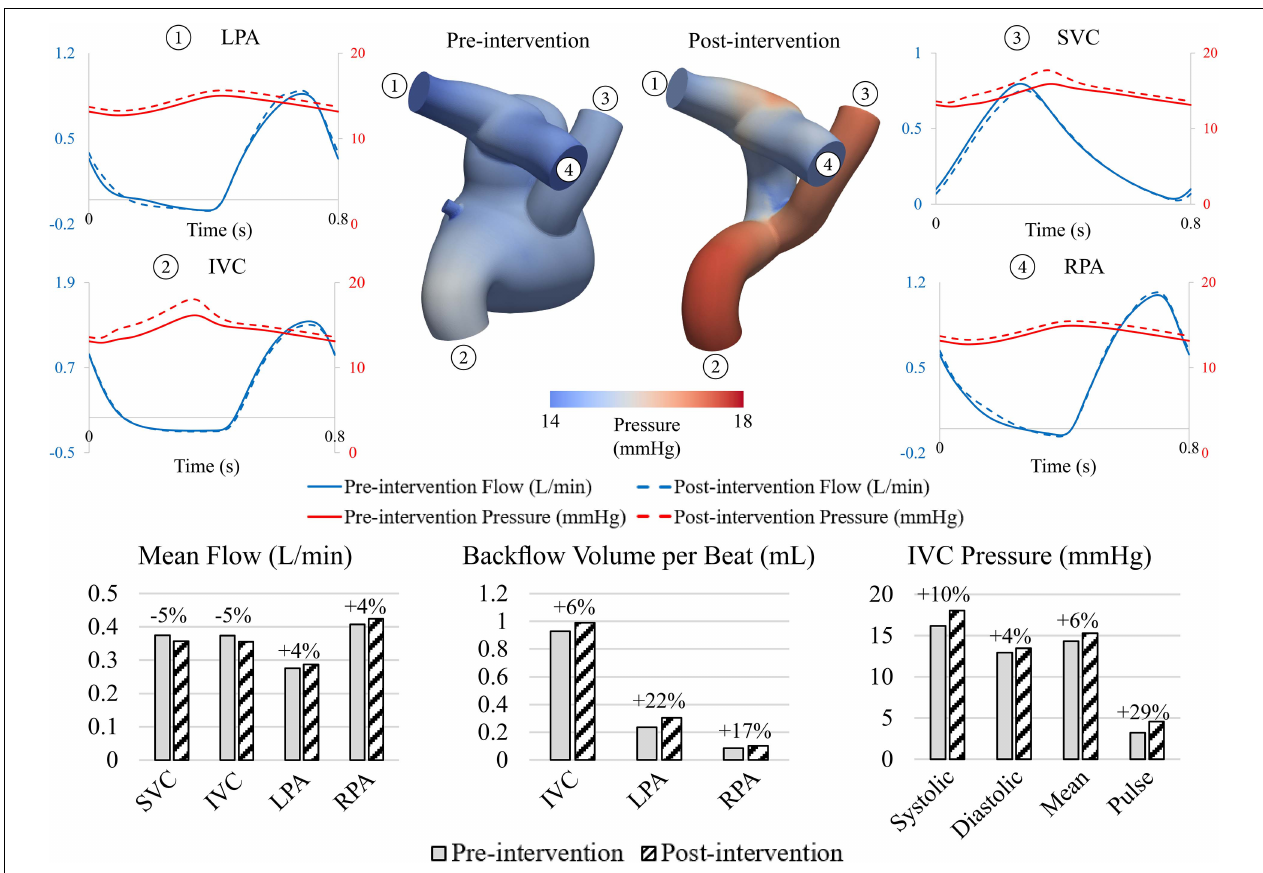
FIGURE 7 | Comparison between pre- and post-intervention hemodynamics. Endovascular intervention led decreases in mean flow and increases in mean pressure at IVC and SVC and increases in backflow at the IVC.